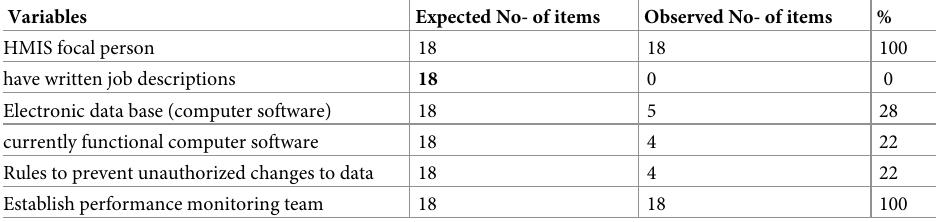
Table 2. General structure and capability of HMIS in health centers of Hadiya Zone, southern, Ethiopia